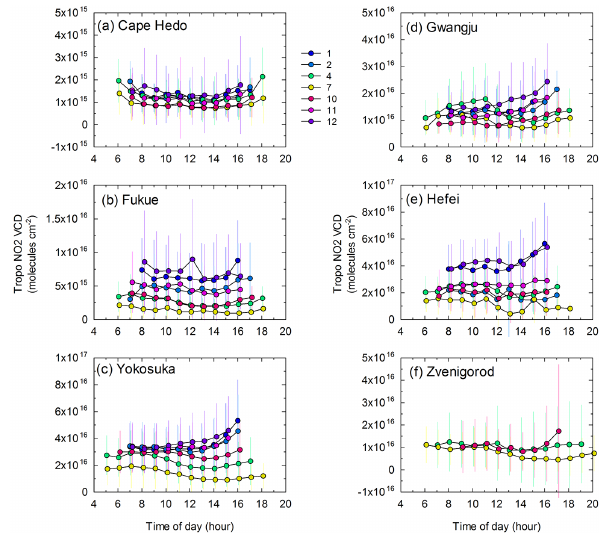
Figure 13. Average diurnal variations in TropoNO2VCD for se- lected months (differently colored). Error bars represent the 1 σ range of the included data.